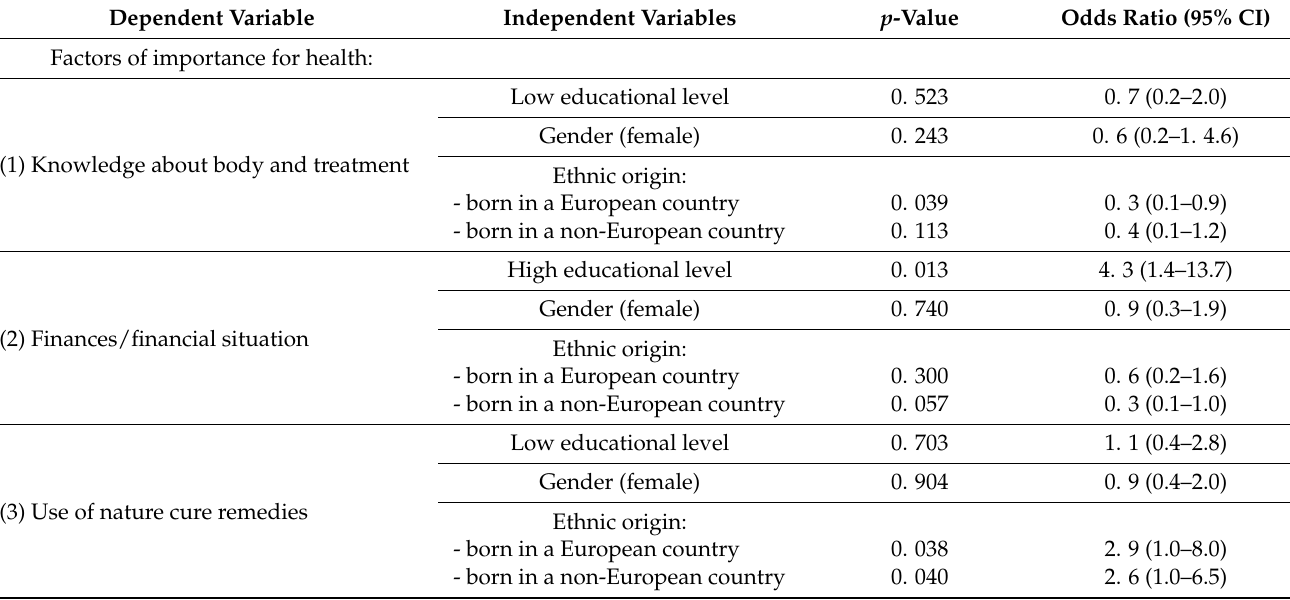
Table 6. Multifactorial influence on factors of importance for health among migrants and Swedish- born persons diagnosed with type 2 diabetes living in Sweden. Results from multiple logistic regression analysis with significant influence shown for independent